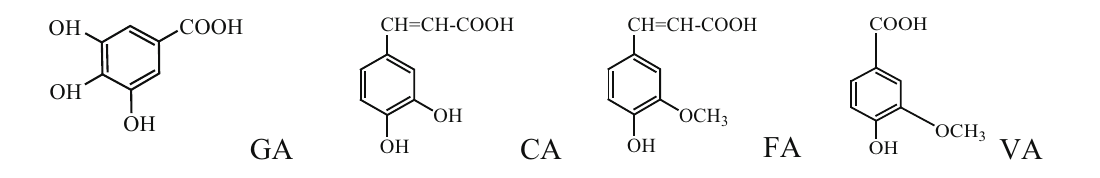
Figure 7: The structure of four polyphenolic